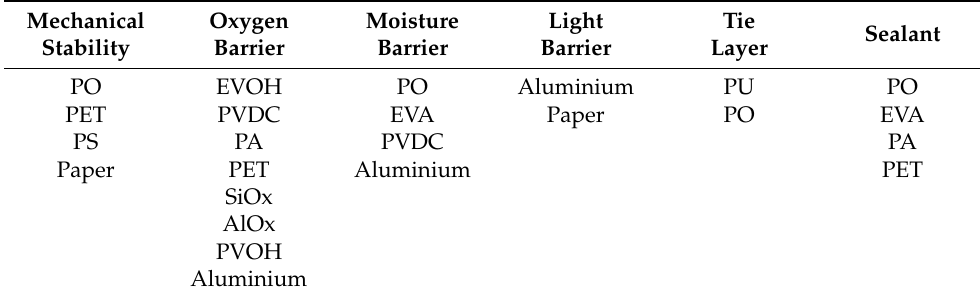
Table 1. Properties and materials in multilayer flexible food packaging. Modified after the work in [13] based on the works in [51,85,86].